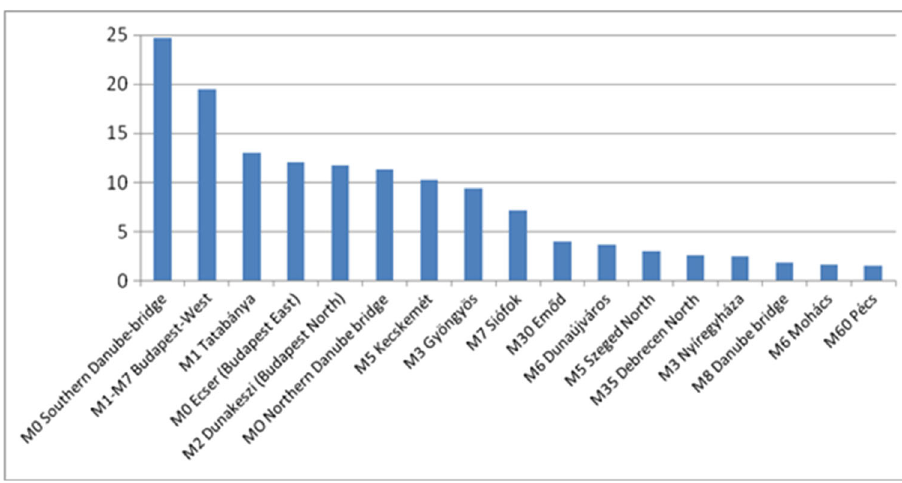
Fig. 3 Traffic intensity per lane in different cross-sections on the motorway network of Hungary in 2010 (data in thousand unit vehicles (~PCUs) per lane per day). Source of data: Hungarian Roads (Magyar Közút Nonprofit